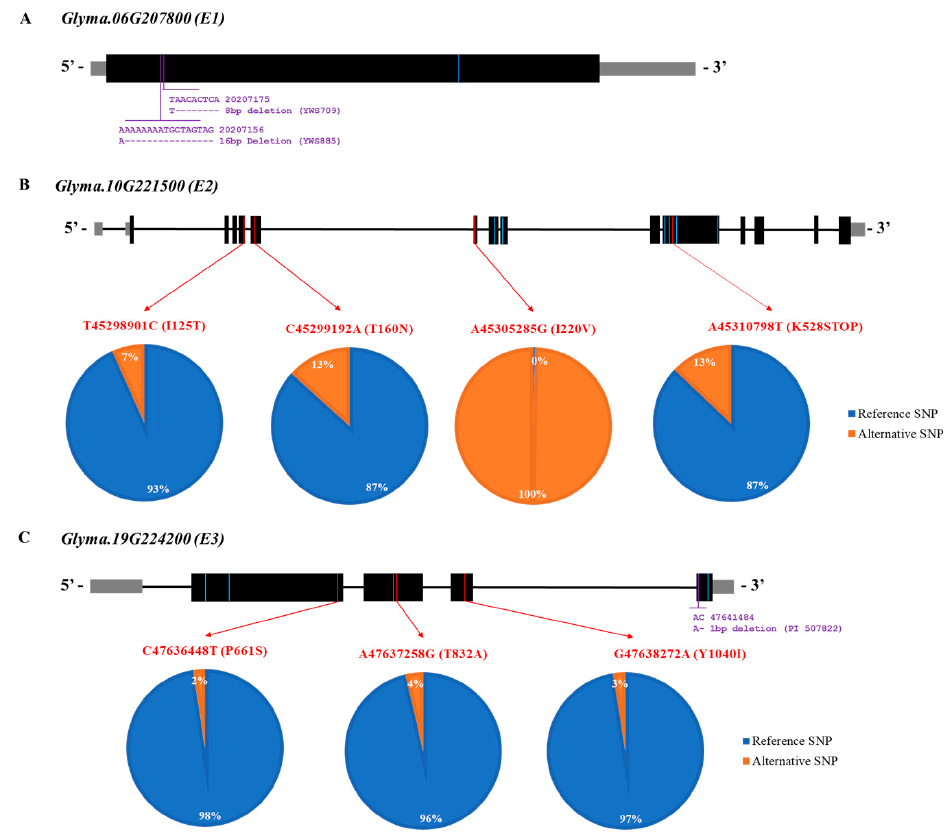
Figure 6. Gene structures of E1 , E2 , and E3 are shown with their variants of sequenced wild soybean accessions. ( A ) Gene model of Glyma.06G207800 ( E1 ), where black boxes indicate exon regions, gray boxes indicate the untranslated region, and black lines indicate the intron region. Blue color indi- cates a silent mutation of E1 . ( B ) Gene model of Glyma.10G221500 ( E2 ), where black boxes indicate exon regions, gray boxes indicate the untranslated region, and black lines indicate the intron region. Missense and nonsense mutations in the exon regions are marked with red lines. Blue indicates a silent mutation of E2 . The reference SNP indicates the Glycine max Wm82.a2 reference genome. The pie charts indicate the proportion of reference and alternative SNPs for missense and nonsense mu- tations. Blue color indicates the reference SNP which is W82.a2.v1, while orange color indicates the alterative SNP which is di ff erent from SNP of Williams 82 ( C ) Gene model of Glyma.19G224200 ( E3 ), where black boxes indicate exon regions, gray boxes indicate the untranslated region, and black lines indicate the intron region. Missense mutations in the exon regions are marked with red lines. Blue indicates a silent mutation of E3 . The proportions of reference and alternative SNPs are shown in pie charts. Blue color indicates the reference SNP which is W82.a2.v1, while orange color indicates the alterative SNP which is di ff erent from SNP of Williams 82 3. Discussion The current study used 1467 wild soybean collections from the National Agrobiodi- versity Center of South Korea to construct 408 Korean wild core collections based on 180 K Axiom ® SoyaSNP genotypic information. Although wild soybean germplasms increase genetic diversity and have favorable genes [3,4], it is challenging to grow wild soybean because of its undesirable traits, such as lodging, viny growth habits, hard seed coats, and pod sha tt ering. Constructing a core subset is one of the strategies to overcome the han- dling of a large population of wild soybean accessions. In this study, the 180 K SNP mark- ers were analyzed to directly re fl ect the genetic diversity of the total population, in con- trast to phenotypic observations that are primarily in fl uenced by environmental factors. Our previous study revealed 430 Korean core collections of G. max from 2872 collections based on the 180K SNP genotype [37–40]. Additionally, we recently provided resequenc- ing data on the core collection of G. max and wild soybeans [38]. The Korean core collection